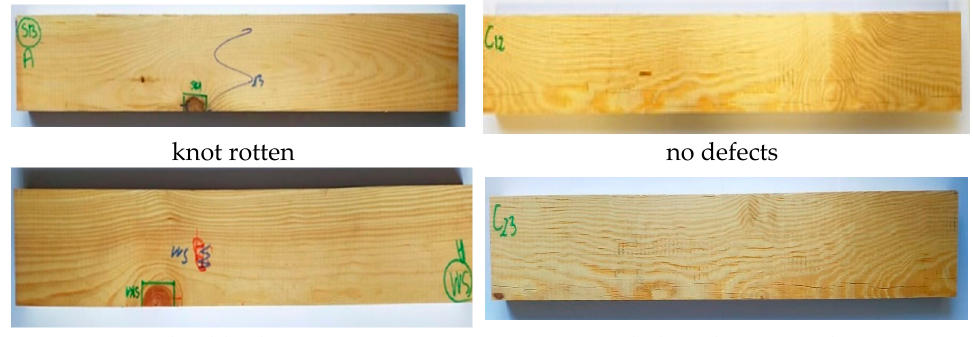
Figure 1. Surface appearance of lumber without and with defects.